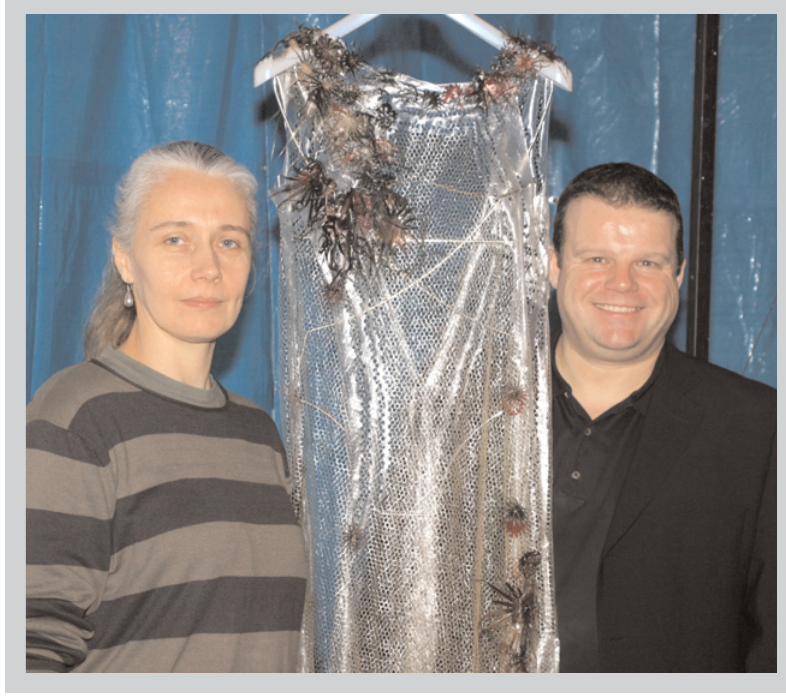
Figure 1: Helen Storey and Professor Tony Ryan with the “Won- derland” dissolving